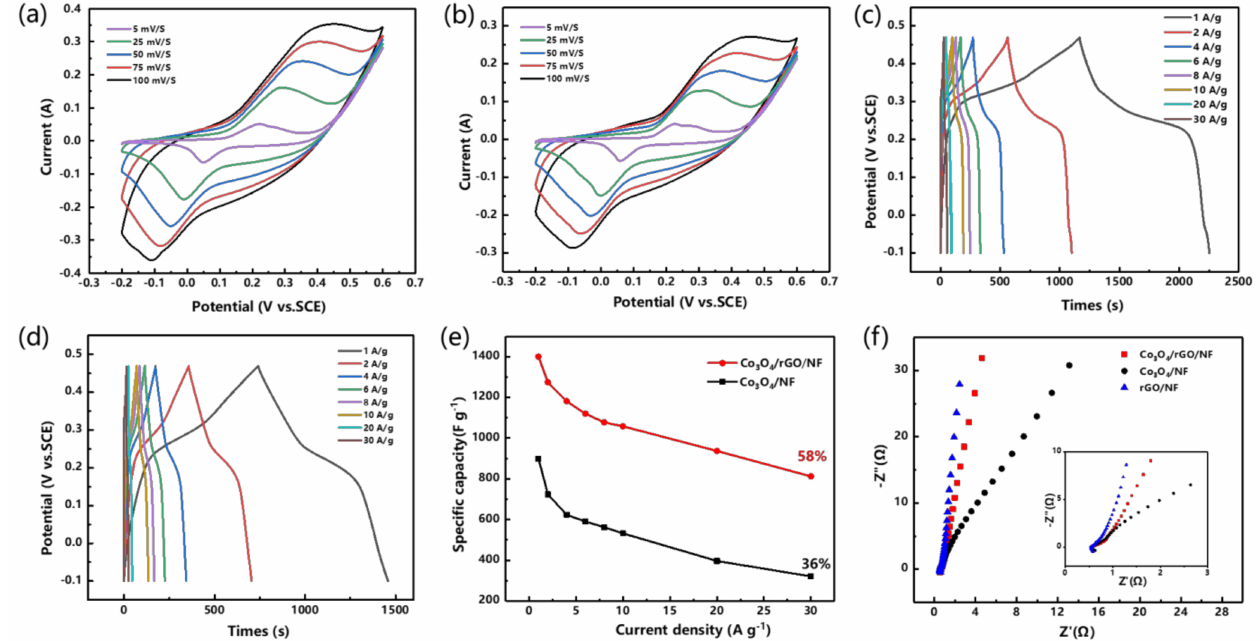
Figure 5. ( a , b ) CV curves of Co 3 O 4 /rGO/NF and Co 3 O 4 /NF electrodes under different scan rates. ( c , d ) GCD curves of Co 3 O 4 /rGO/NF and Co 3 O 4 /NF electrodes under different current densities. ( e ) Specific capacitance curves of Co 3 O 4 /rGO/NF and Co 3 O 4 /NF electrodes under different cur- rent densities. ( f ) Nyquist plots of Co 3 O 4 /rGO/NF, Co 3 O 4 /NF, and rGO/NF electrodes (inset: High − frequency